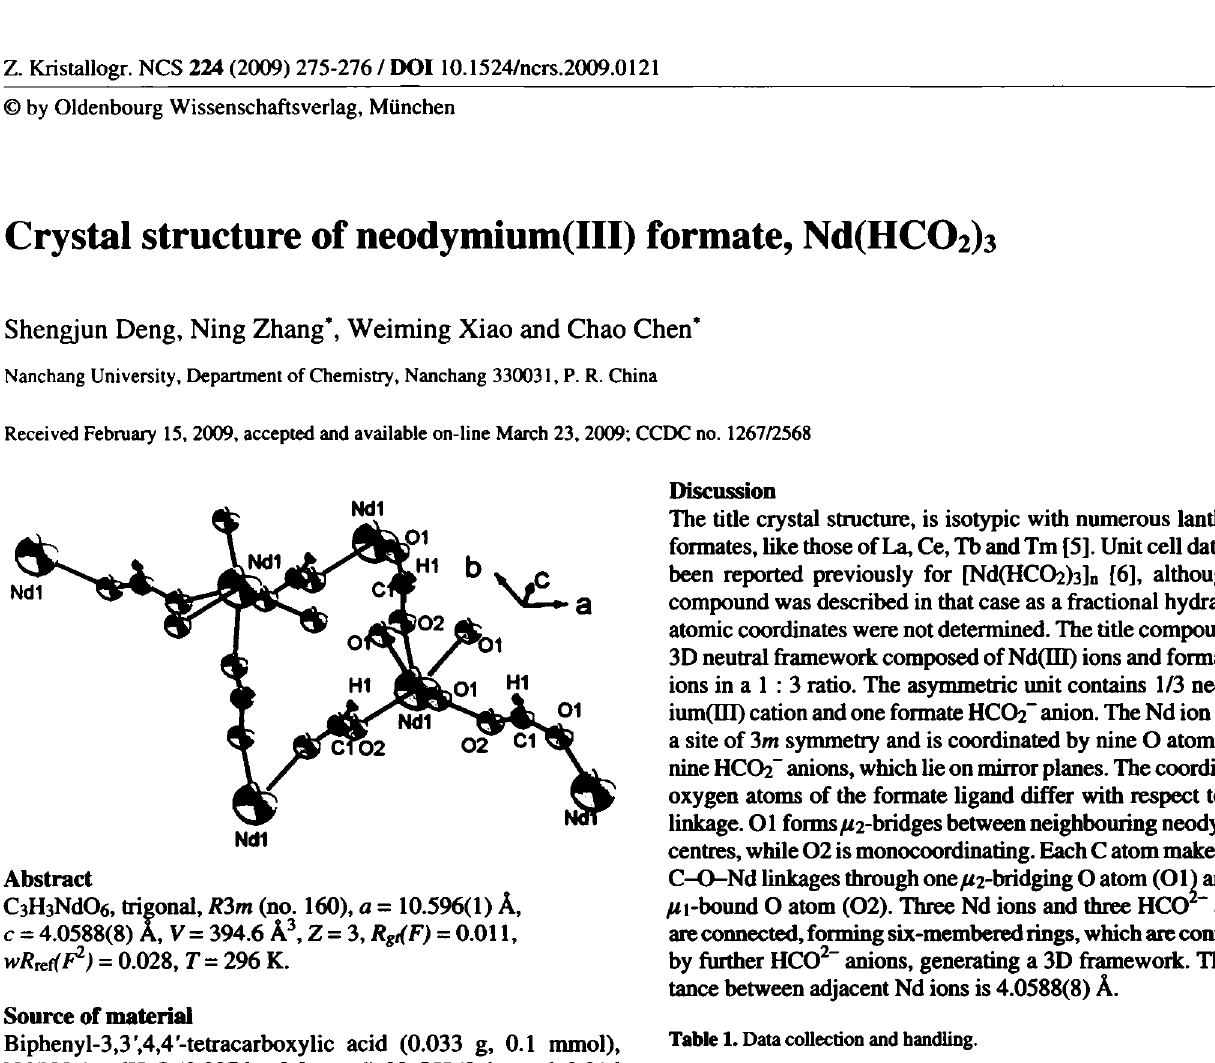
Table 1. Data collection and handling.